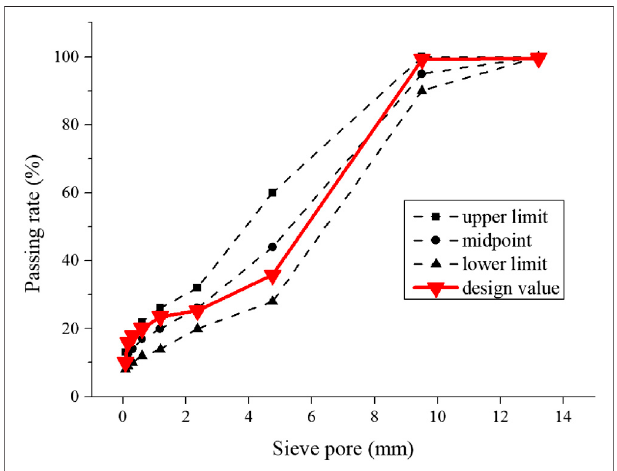
FIGURE 1 | Grading curve of SMA-10.